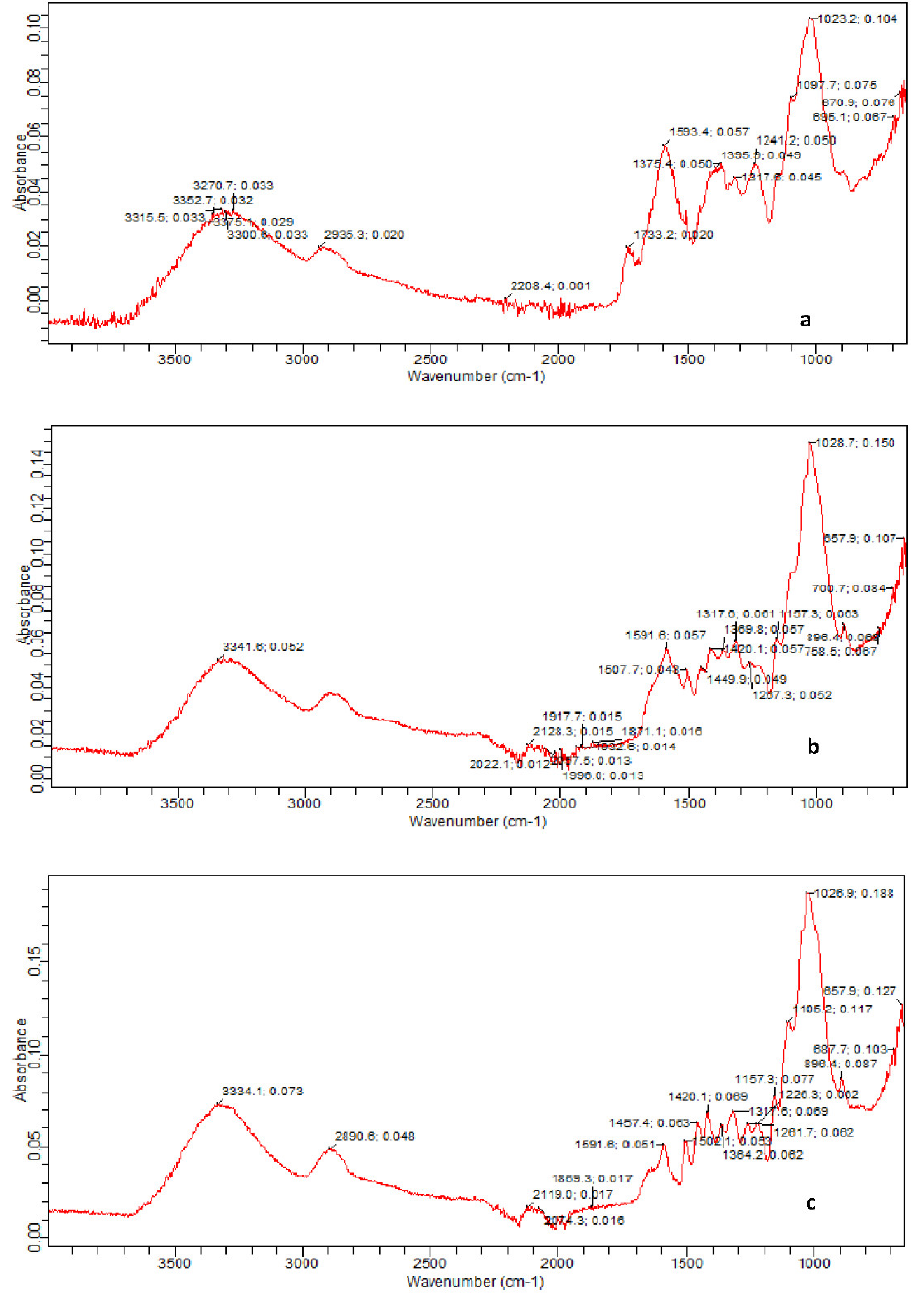
Figure 2. FTIR spectroscopy images of ( a ) untreated, ( b ) KOH-pretreated, and ( c ) KOH-steam-pretreated B. ceiba .